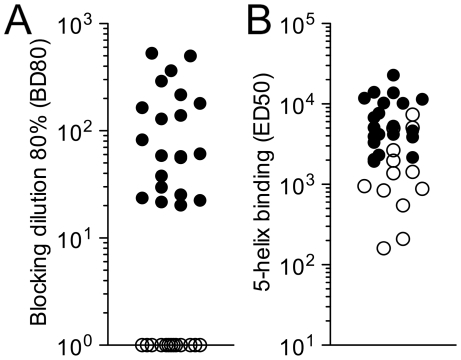
Detection of HK20-like antibodies in patient sera.(A) ELISA plates were coated with 5-Helix and incubated with serial plasma dilutions, followed by biotinylated HK20 mAb and by enzyme-conjugated streptavidin. Shown is the reciprocal plasma dilution that blocks 80% binding (BD80) of HK20 mAb. BD80 values <20 (empty circles) were scored as negative. Each symbol represents a different individual. (B) Total serum IgG binding to 5-Helix was determined by ELISA. Reciprocal EC50 values are shown. Empty circles correspond to plasma samples with BD80 values <20.